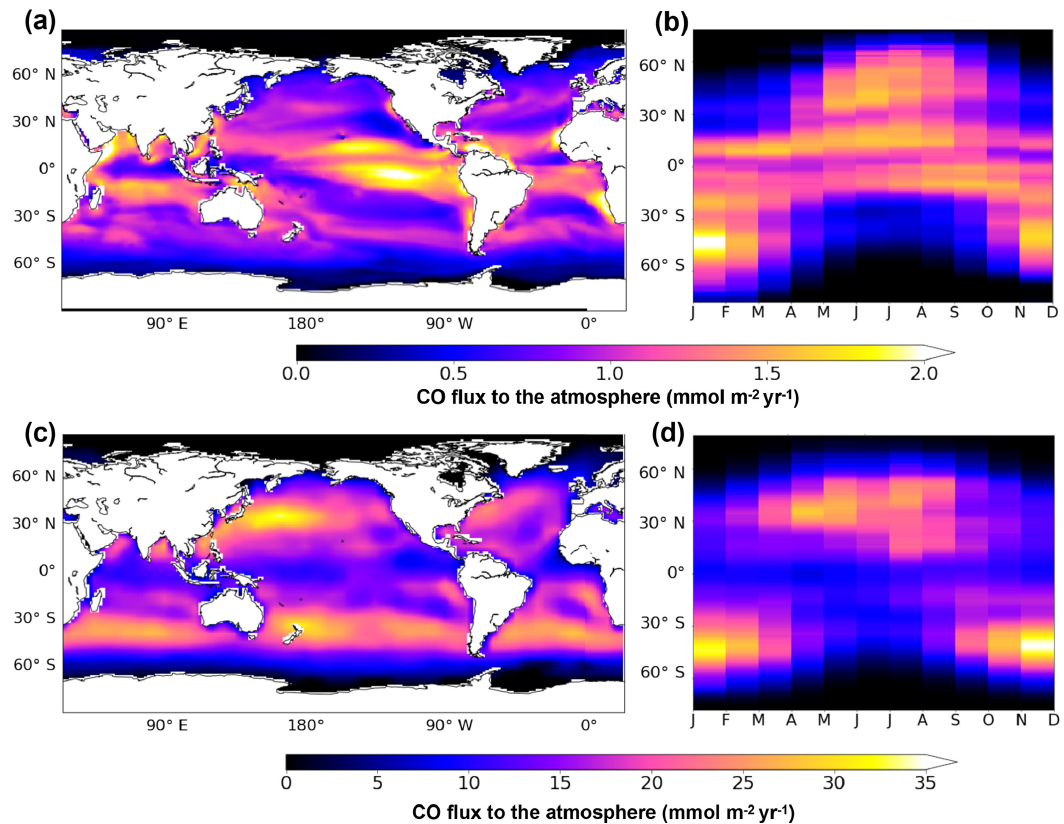
Figure 9. Oceanic CO emissions simulated by PISCES (a, b) or by the model of Erickson (1989) (c, d) . Panels (a) and (c) present the spatial distribution of annual mean emissions. Panels (b) and (d) present the mean seasonal variation with latitude. All fluxes are in mmolm − 2 yr − 1 and are directed toward the at